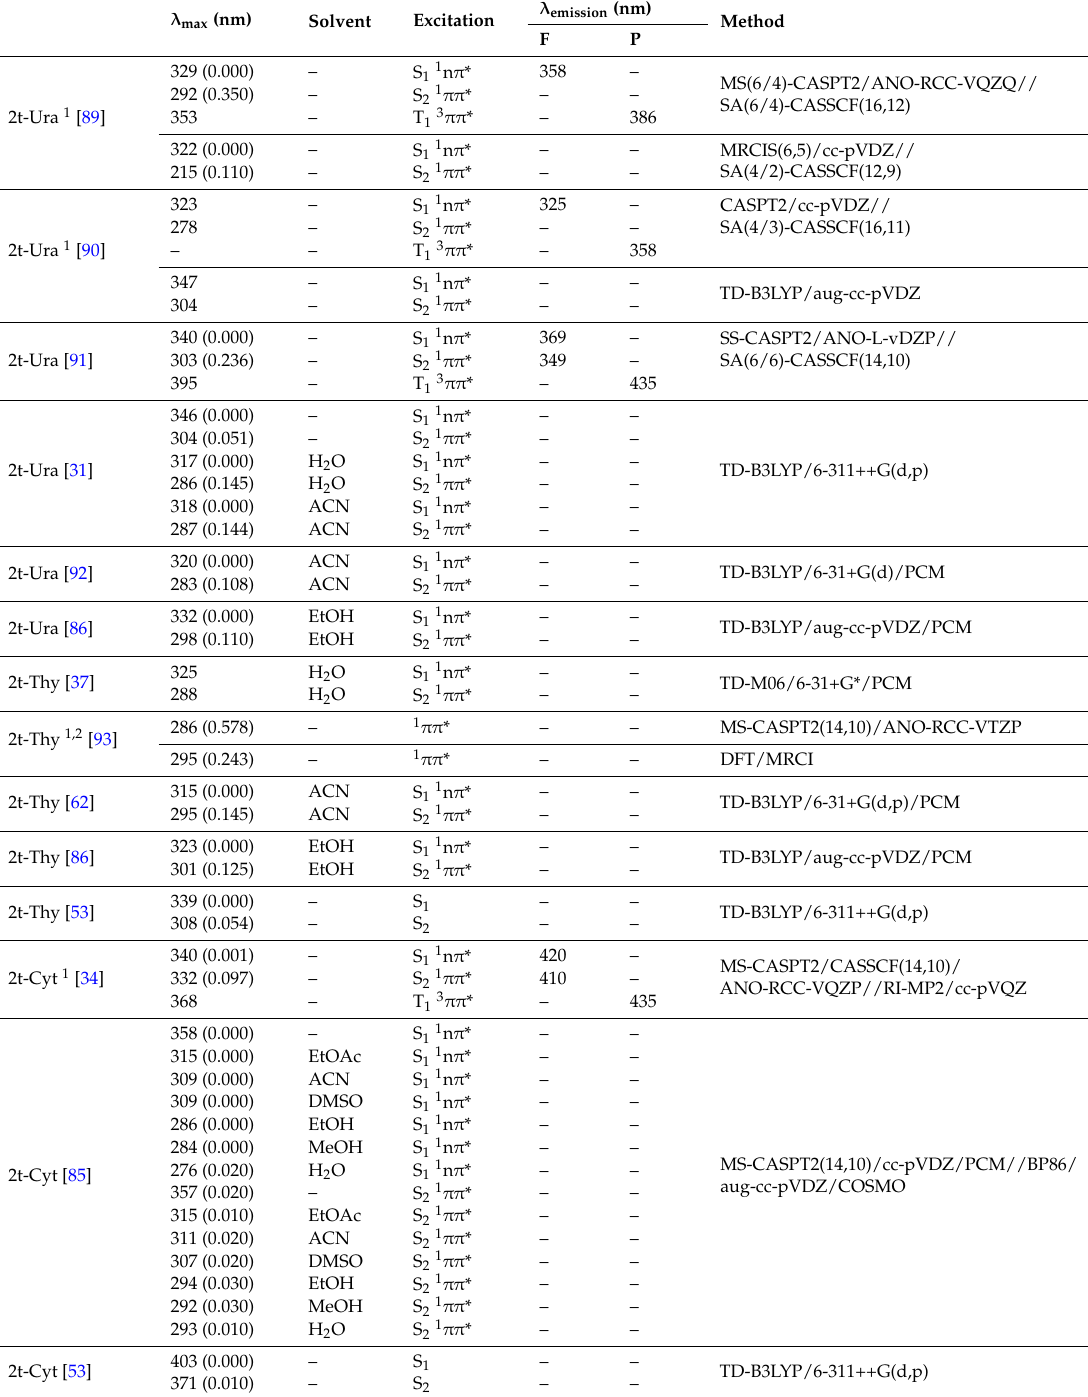
Table 5. Computed absorption and emission properties of 2-thiopyrimidine derivatives. Only information concerning the lowest lying spectroscopic state and preceding states is included. In parenthesis the oscillator strengths are shown. F: Fluorescence; P: